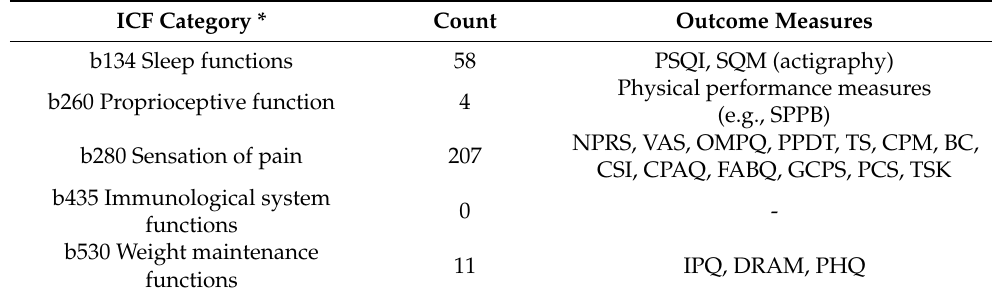
Table 2. Comparison with the Brief ICF Core Set for Post-Acute Musculoskeletal